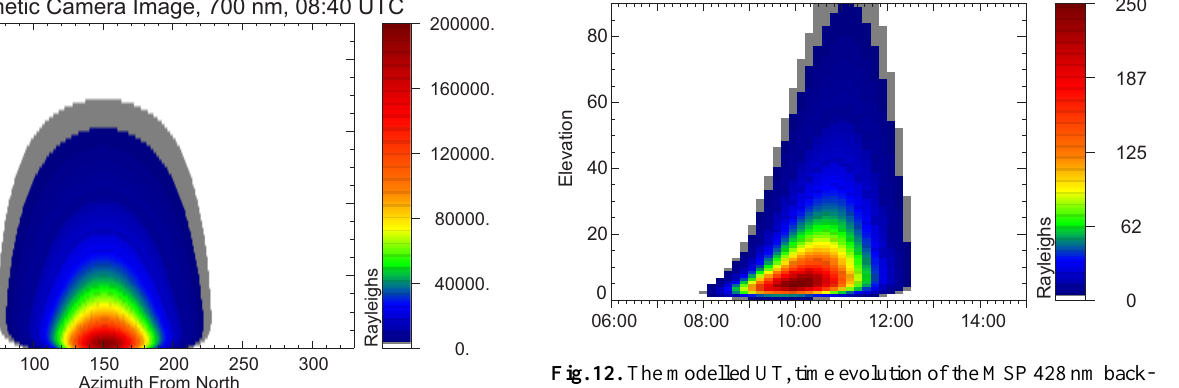
Fig. 12. The modelled UT, time evolution of the MSP 428nm back- ground continuum data on 6 December 2002. This figure models the observations presented in Fig. 3 but the colour scales are in an approximate ratio of 4:1. The required difference in colour scales is attributed to the wavelength dependence of the PSC integrated vertical